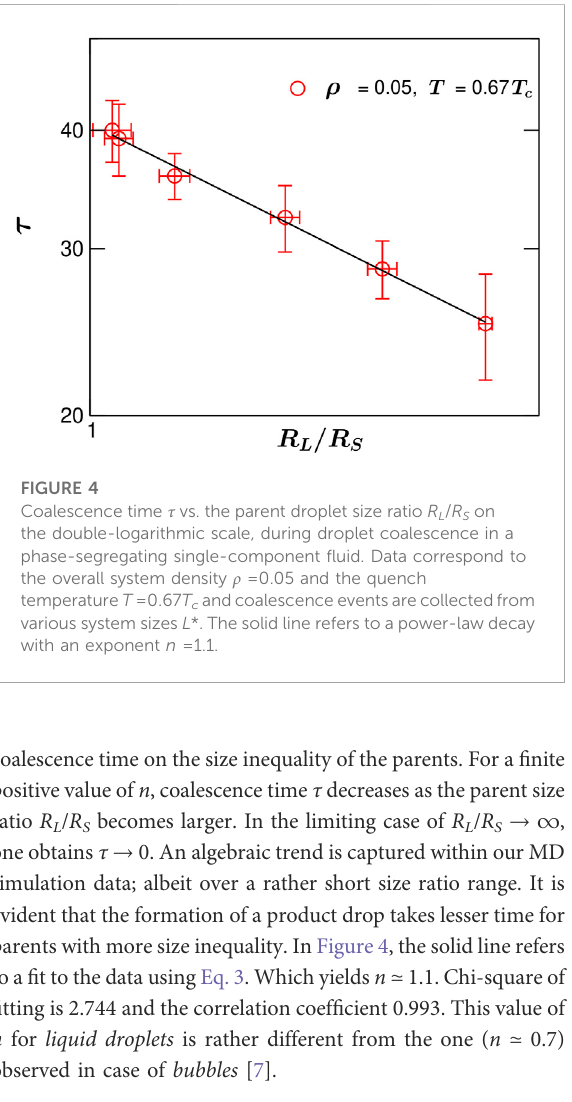
coalescence time on the size inequality of the parents. For a fi nite positive value of n , coalescence time τ decreases as the parent size ratio R L / R S becomes larger. In the limiting case of R L / R S → ∞ , one obtains τ → 0. An algebraic trend is captured within our MD simulation data; albeit over a rather short size ratio range. It is evident that the formation of a product drop takes lesser time for parents with more size inequality. In Figure 4, the solid line refers to a fi t to the data using Eq. 3. Which yields n ≃ 1.1. Chi-square of fi tting is 2.744 and the correlation coef fi cient 0.993. This value of n for liquid droplets is rather different from the one ( n ≃ 0.7) observed in case of bubbles [7].